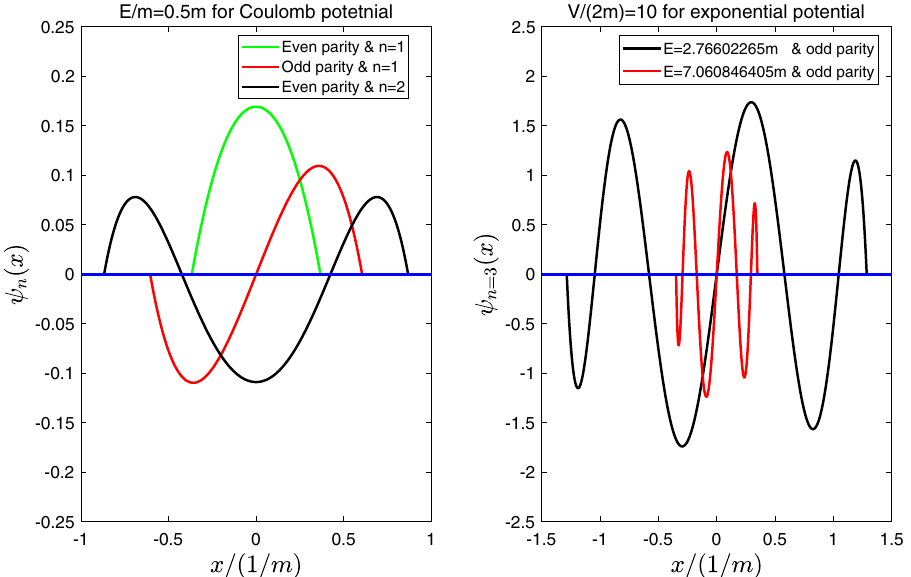
Figure 5. The (un-normalized) wave functions for BIC. ( a ) The wave functions for Coulomb potential. Here we take the bound state energy E =2m for all the wave functions. ( b ) the two wave functions of n number nodes for exponential potential with potential strength V /( 2 m ) Fig. 5, we can see that outside the effective potential well which is given by (